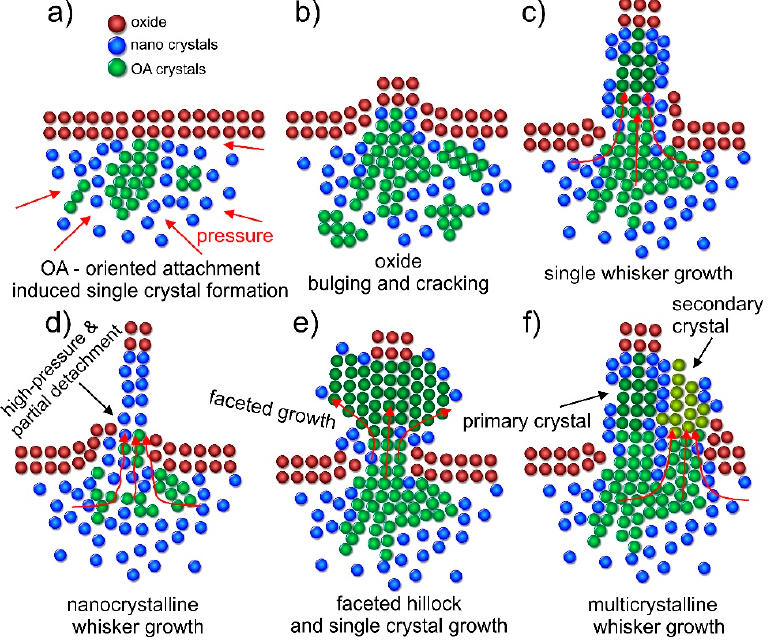
Figure 9. Schematic representation of the different crystallization growths caused by recrystallization and oriented attachment in the Bi-Mg-Pb pools. For clarity, the amorphous portion of the Pb material is not presented. ( a ) presents the agglomeration of nanocrystals at specific positions with their rearrangement formed by oriented attachment. ( b ) presents the bulging of the underlying material from the material’s surface that occurs due to cracking of the overlying oxide layer. The subsequent sketches present the growth and development of ( c ) a single-crystalline whisker, ( d ) nanocrystalline whisker, ( e ) faceted single-crystalline hillock and ( f ) multicrystalline whisker with subsequent secondary crystal growth.